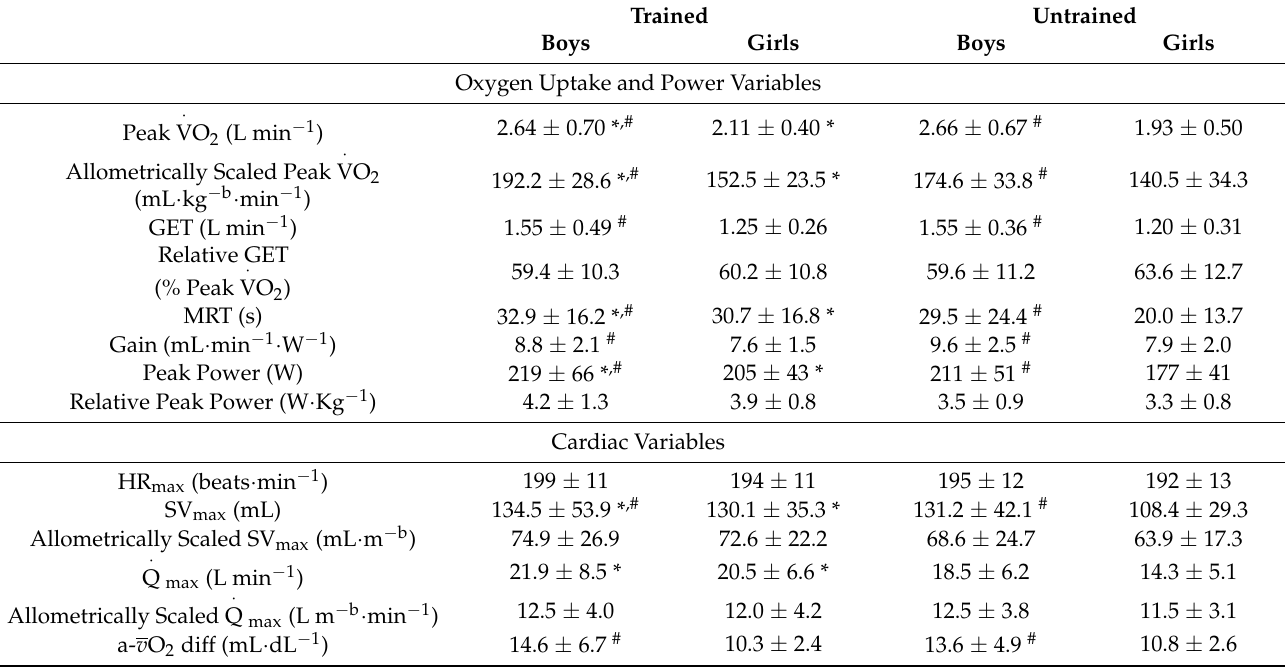
Table 2. Pulmonary gas exchange and hemodynamic responses to incremental ramp exercise accord- ing to training status and